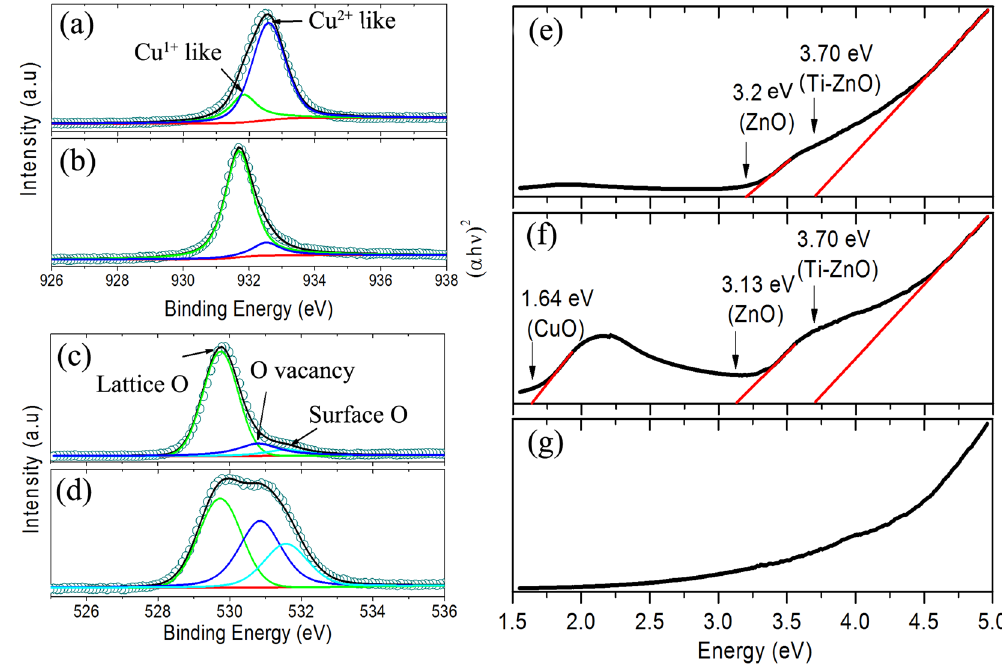
Figure 2. XPS spectra of ZnO:Cu films. ( a ) Cu 2p 3/2 edge, PO 2 = 10 − 3 torr. ( b ) Cu 2p 3/2 edge, PO 2 = 10 − 5 torr. ( c ) O 1 s edge, PO 2 = 10 − 3 torr. ( d ) O 1 s edge, PO 2 = 10 − 5 torr. ( e ) ( α hV )2 versus photon energy plots of ZnO:Cu films at PO 2 = 10 − 3 and 10 − 5 torr,